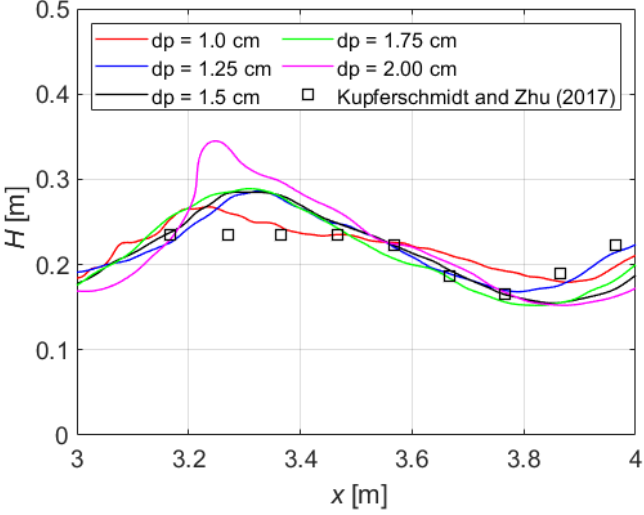
Figure 4. Centerline water-surface elevation along the selected section of VUS case for α = 0.01 and various dp .